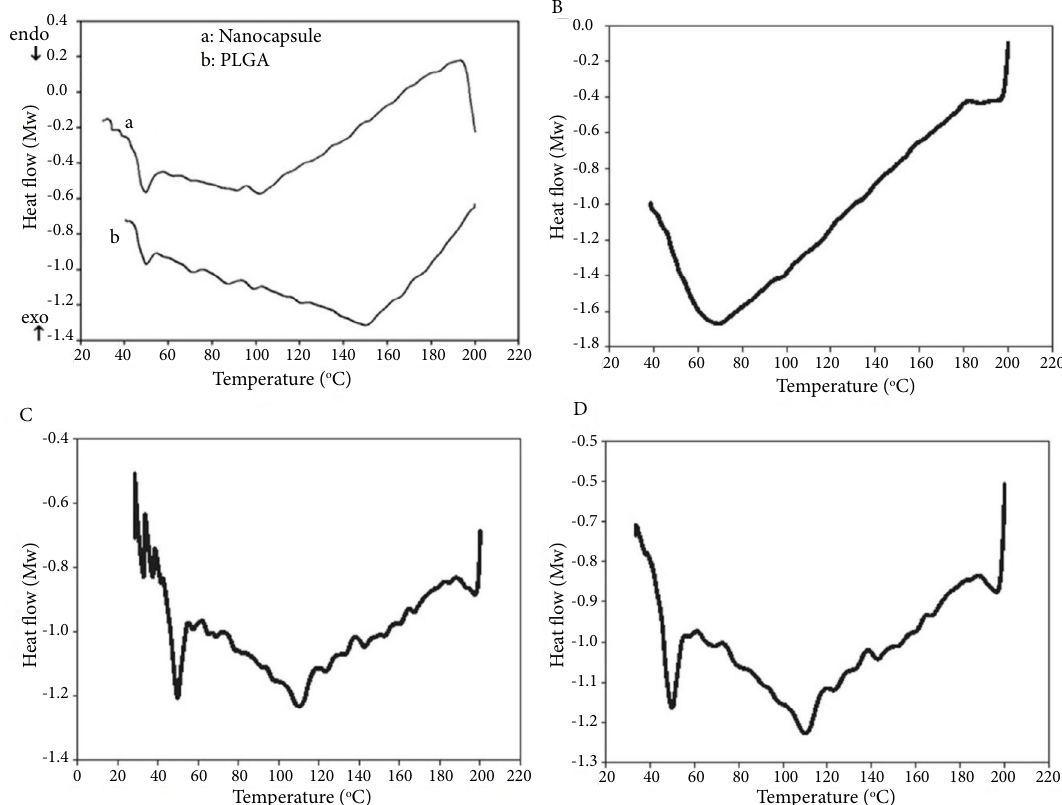
Fig. 5. DSC thermograms of (A) pure PLGA and nanocapsule of PLGA; (B) pure BSA; (C) nanocapsule of PLGA/BSA, 0.25/0.25 w/v (D) nanocapsule of PLGA/BSA,